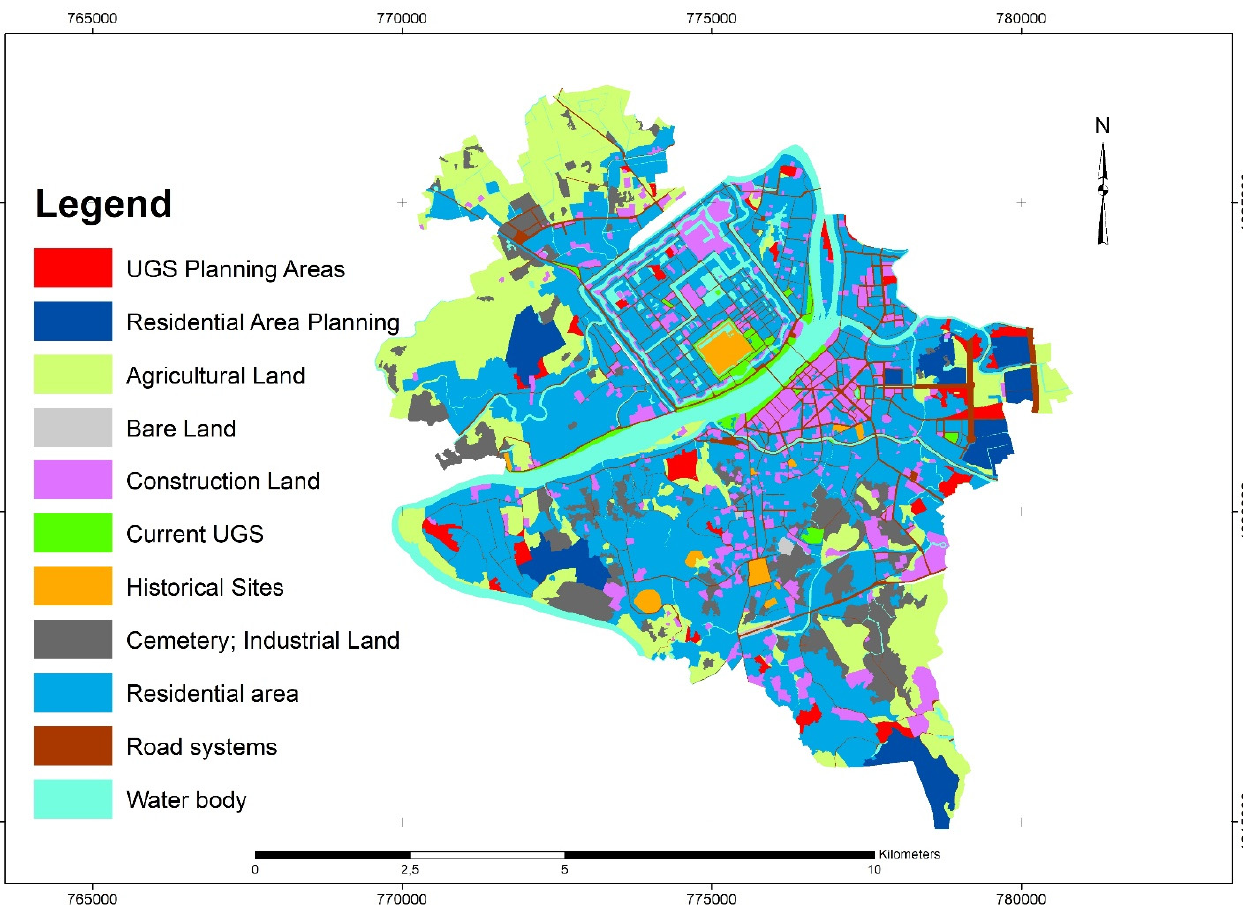
Figure 9. Map of the suggested UGSs for land use planning in 2030 in Hue City ( sources: authors; Land Use Planning Project of Hue City in 2030 ).